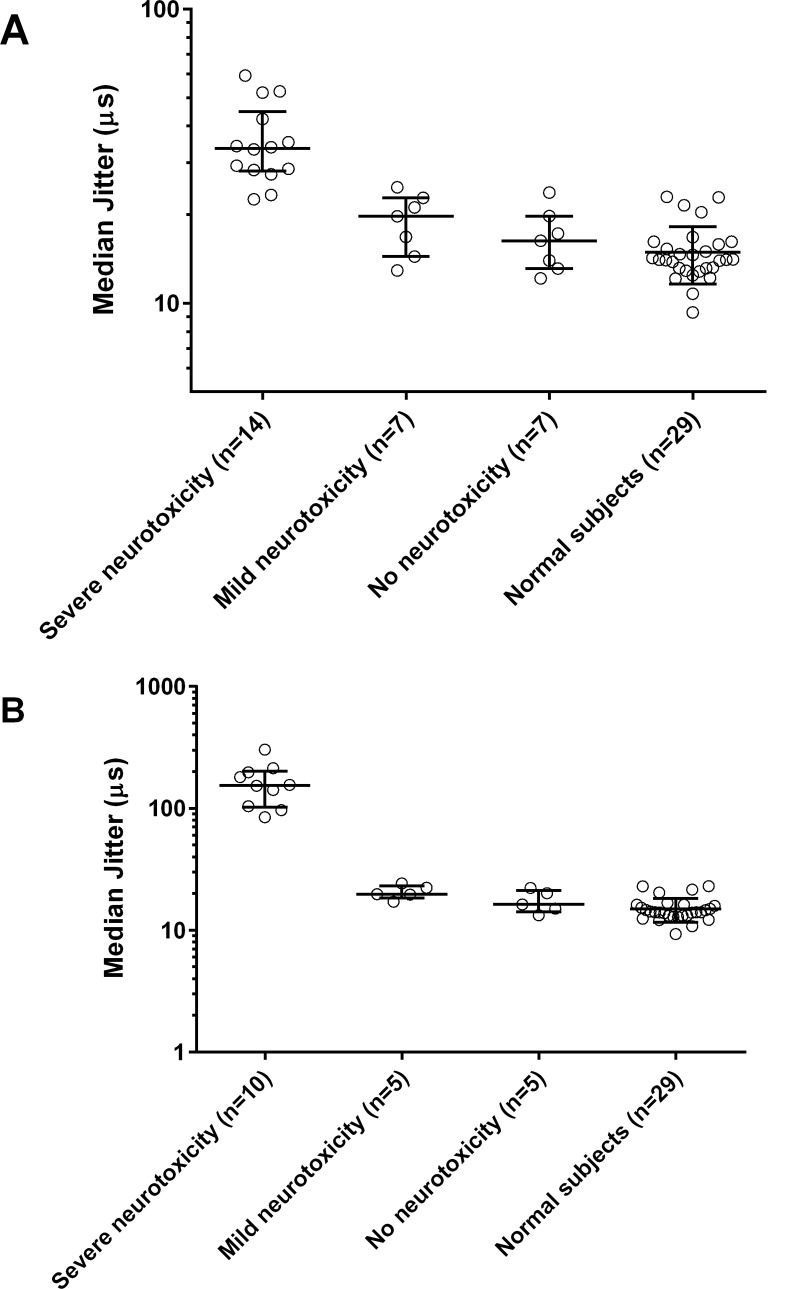
sfEMG jitter comparison across no, mild and severe neurotoxicity groups.Scatter plots of the median MCD in jitter of the three groups of patients with common krait bites on admission (A) and 6–12 hours after the bite (B) compared to the median MCD in jitter values of normal subjects. Median and interquartile range is shown for each group in the graph. On both occasions, the severe neurotoxicity group has significantly high median jitter compared to the normal subjects (P<0.0001; one-way ANOVA followed by multiple comparison test).